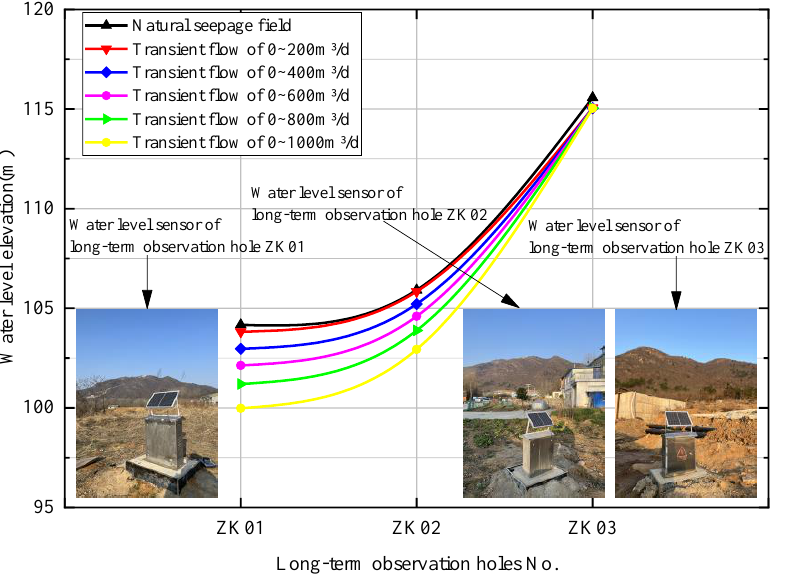
Figure 10. Water level changes in the long observation holes under different transient flows.